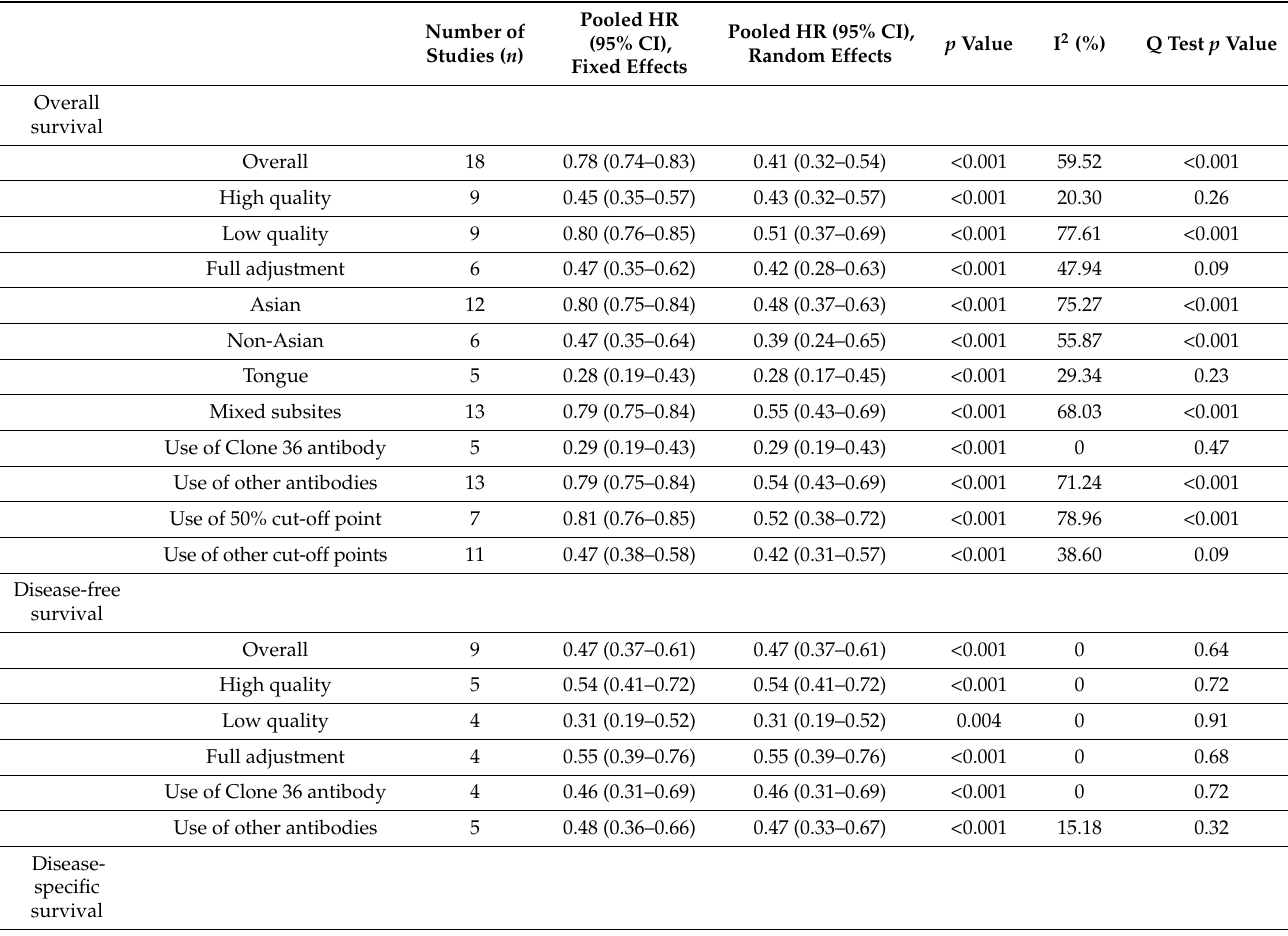
Table 4. Subgroups pooled hazard ratios and 95% confidence intervals for long-term